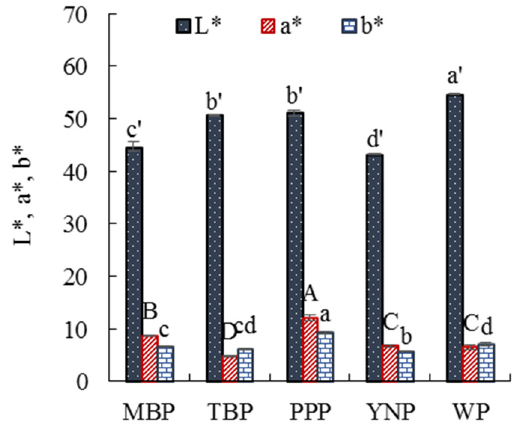
Figure 2. L *, a *, and b * of the five types of pork. Values are shown as the mean ± standard deviation. Different letters above the bars of standard deviations indicate significant differences ( p < 0.05); MBP, manor black pigs; TBP, Tibetan black pigs; PPP, Pipa pigs; YNP, Yihao native pigs; and WP, white pigs.